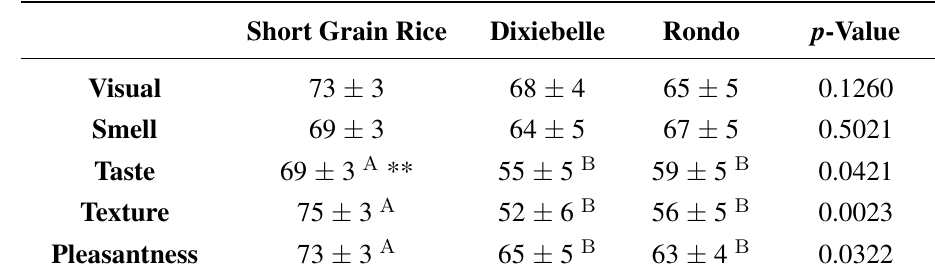
Table 5. Treatment palatability (mean ± SEM) from VAS assessment * in healthy adults ( n =